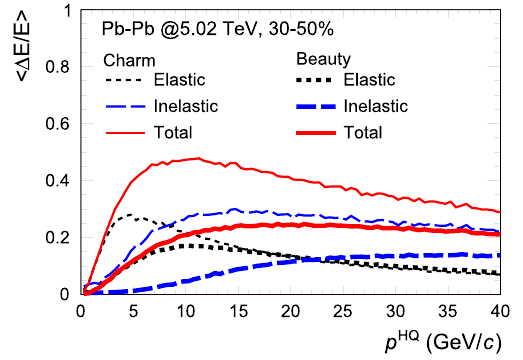
Fig. 2 Comparison of the average in-medium energy loss fraction, for charm (thin curves) and beauty quarks (thick curves), displaying sep- arately the contributions from collisional (dashed black curves) and radiative mechanisms (long dashed blue curves). The combined results (solid red curves) are shown as well for